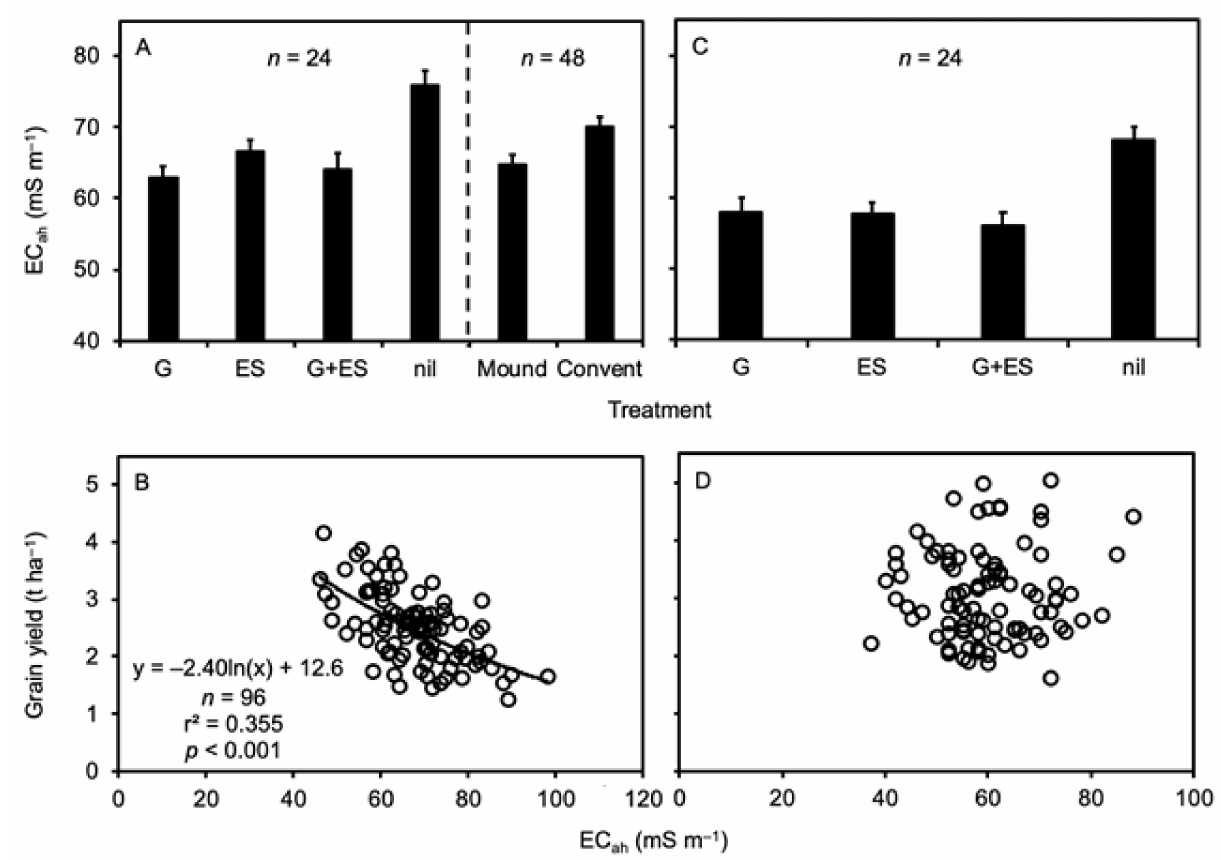
Figure 8. Effects of tillage and amendment treatments on average EM38 readings in the horizontal orientation (EC ah ) ( A , C ) and the relationship between EC ah and grain yield ( B , D ). Data were collected in 2019 ( A , B ) and 2020 ( C , D ). EC ah data were collected with the EM38 in the horizontal orientation. Amendments were: nil, gypsum (G), elemental sulfur (ES), and gypsum plus elemental sulfur (G+ES). The soil was a Vertic Calcic Calcisol located on Merredin Research Station ( − 31 ◦ 30 (cid:48) 25 (cid:48)(cid:48) S, 118 ◦ 13 (cid:48) 04 (cid:48)(cid:48)